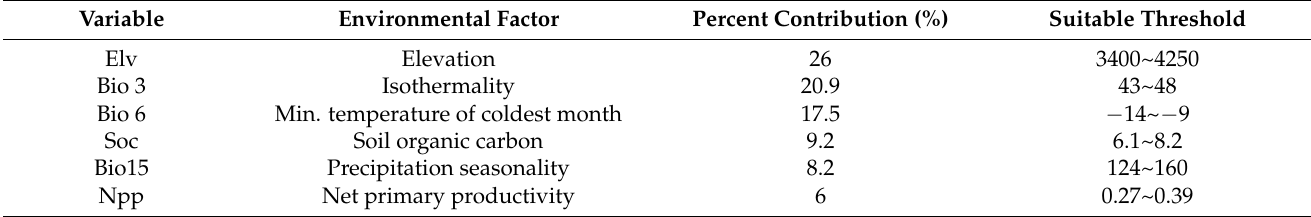
Table 2. The contribution of key environmental factors to modeling S. moorcroftiana (Benth.) Baker habitat distribution derived from the MaxEnt model.